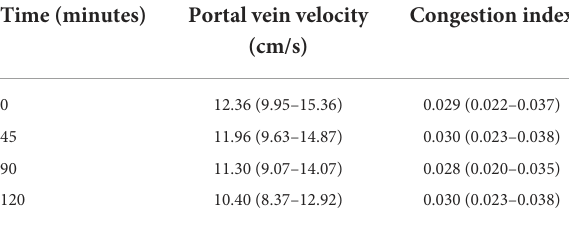
TABLE 3 Average portal vein velocity and congestion index over